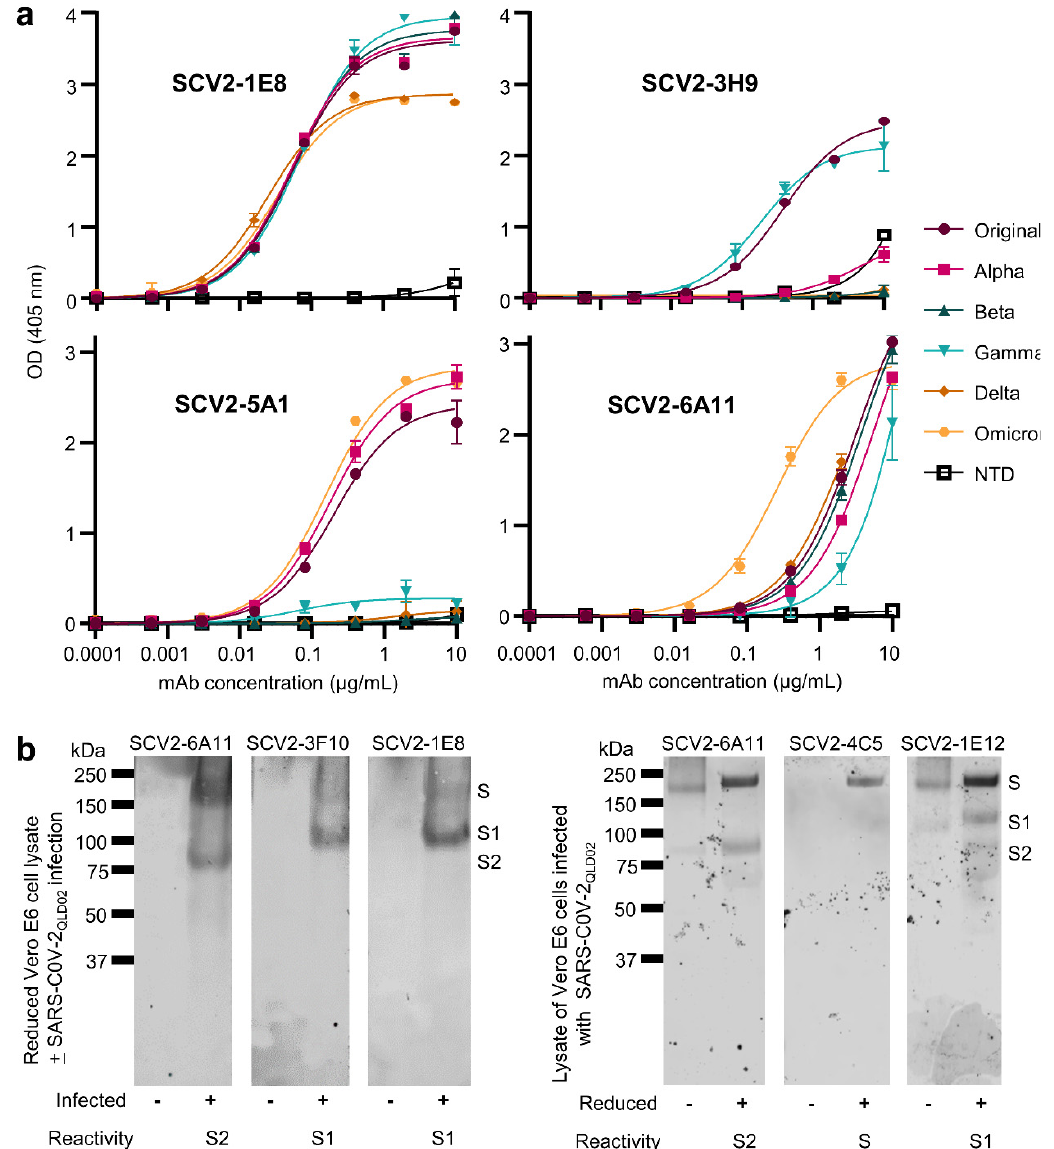
Figure 3. ELISAs and Western blots. ( a ) ELISA curves for the indicated purified mAbs using recombinant HexaPro spike proteins with mutated furin cleavage site from the indicated variants of concern as antigen. ( b ) Western blots using reduced (DDT) lysates of Vero E6 cells with (+) and without ( − ) infection with SARS-CoV-2 QLD02 (left), or lysates of SARS-CoV-2 QLD02 infected Vero E6 cells that were either reduced (+) or not reduced ( − ) (right). The primary reactivity of each mAb is indicated. (Note SCV2-6A11 is used in both